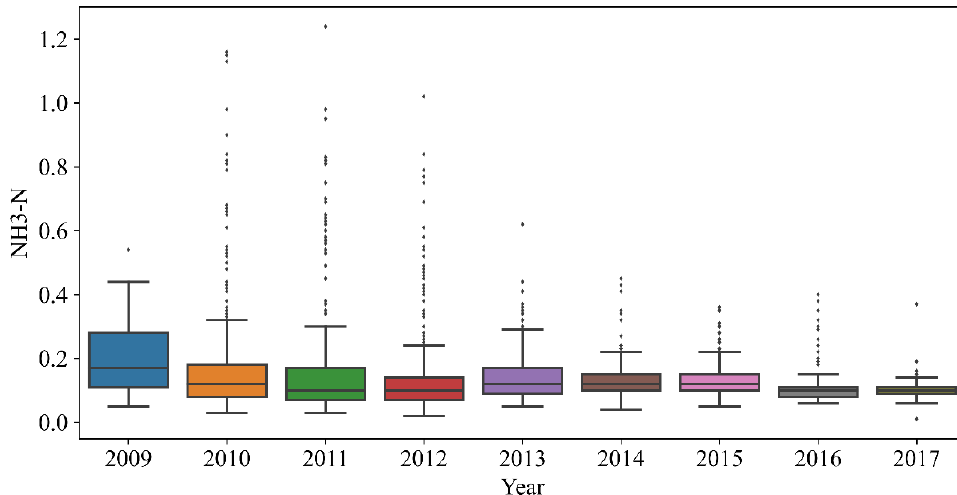
Figure 4. Annual data distribution of water quality indicator NH 3 -N.